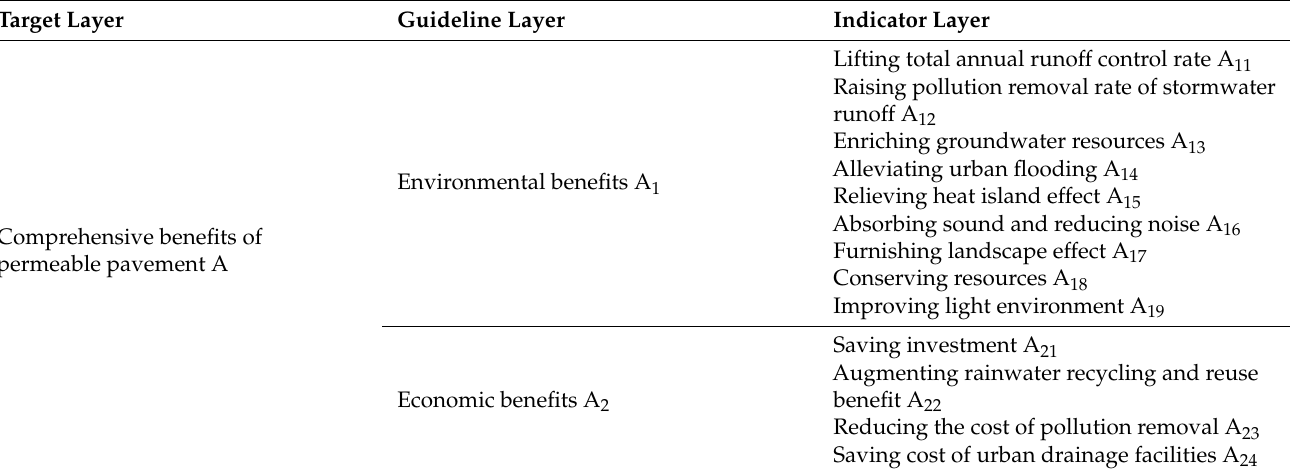
Table 4. The hierarchical structure of the comprehensive benefit evaluation indicator system for permeable